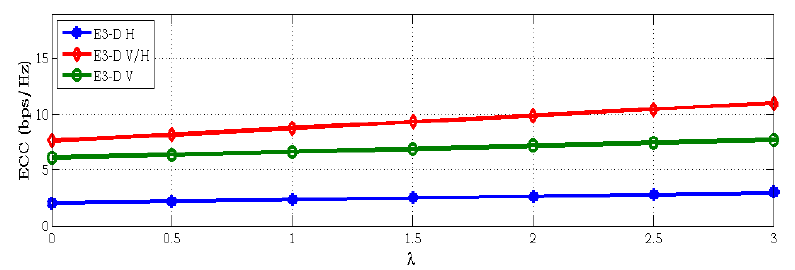
Figure 8. ECC versus receiving antenna spacing on the beam